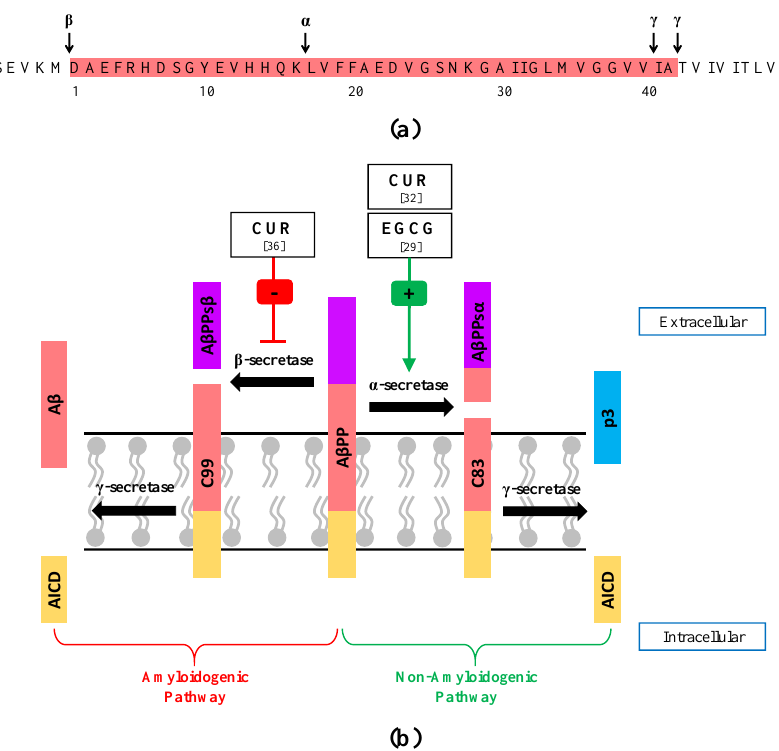
Figure 3. Enzymatic processing of amyloid- β precursor protein (A β PP). ( a ) Cleavage within the amyloid- β (A β ) sequence (i.e., at the peptide bond between Lys16 and Leu17) by α -secretase precludes A β production while sequential cleavages first by β -secretase, and then by γ -secretase at the sites indicated produce A β 40 and A β 42. ( b ) Amyloidogenic and non-amyloidogenic pathways and their products. Curcumin modulates the amyloidogenic pathway by inhibiting β -secretase. EGCG and curcumin facilitate the non-amyloidogenic pathway by enhancing the activity of α